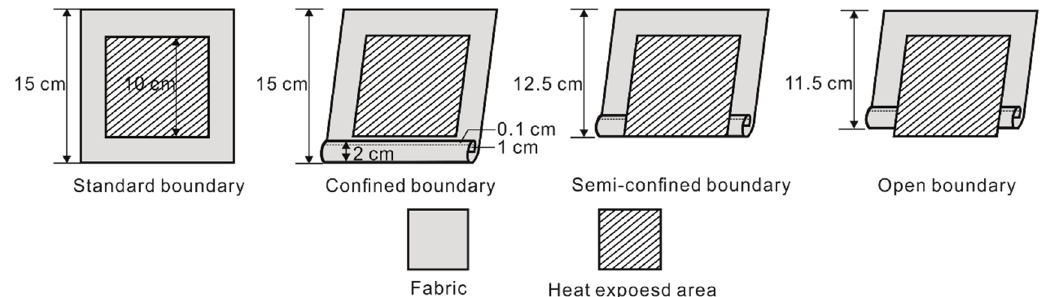
Figure 2. Diagram of four boundary conditions (fabric back side).